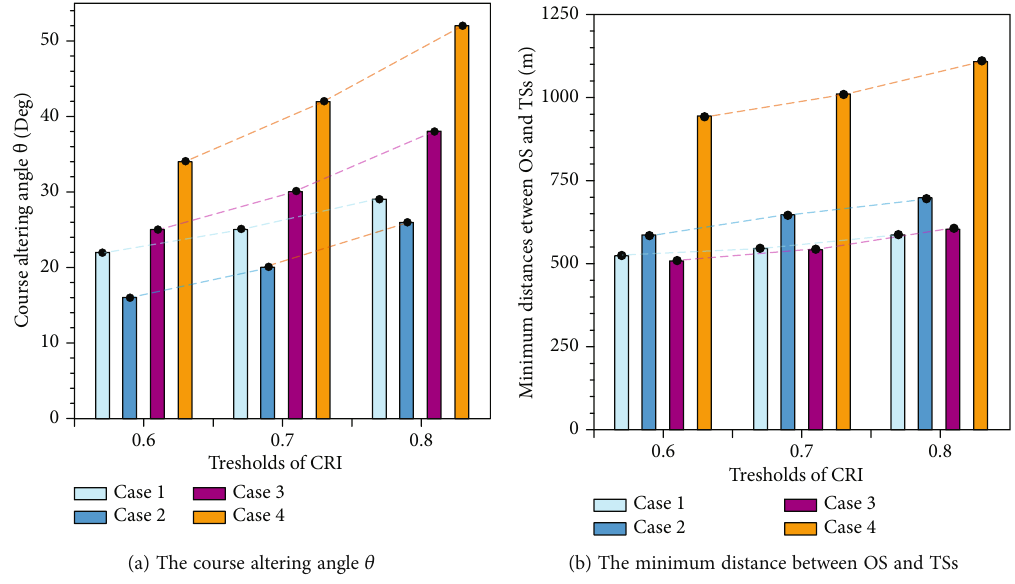
Figure 18: Comparison of the results of di ff erent